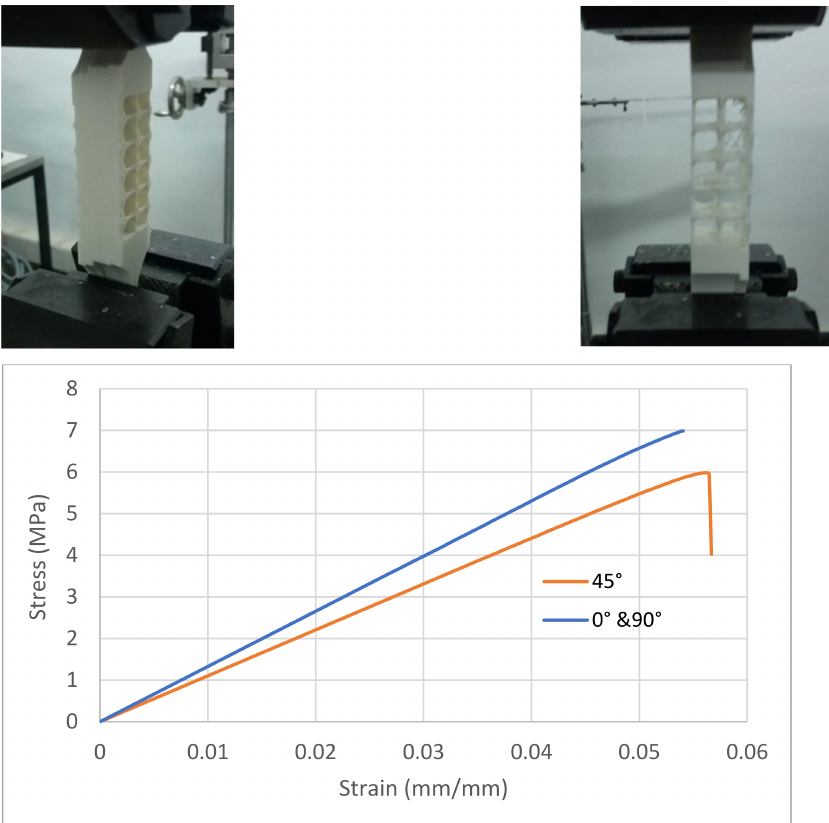
Figure 19. Samples behavior on the tensile strength test, and stress/strain curve of lattice structure #1 for 0 ◦ , 45 ◦ and 90 ◦